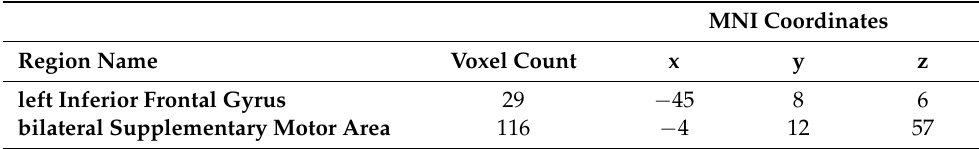
Figure 4. The overlapping activation regions of NA > NR and NV > NR in the bilateral SMA and the left IFG. Table 4. Voxel clusters for the conjunction analysis of NA > NR and NV > NR.